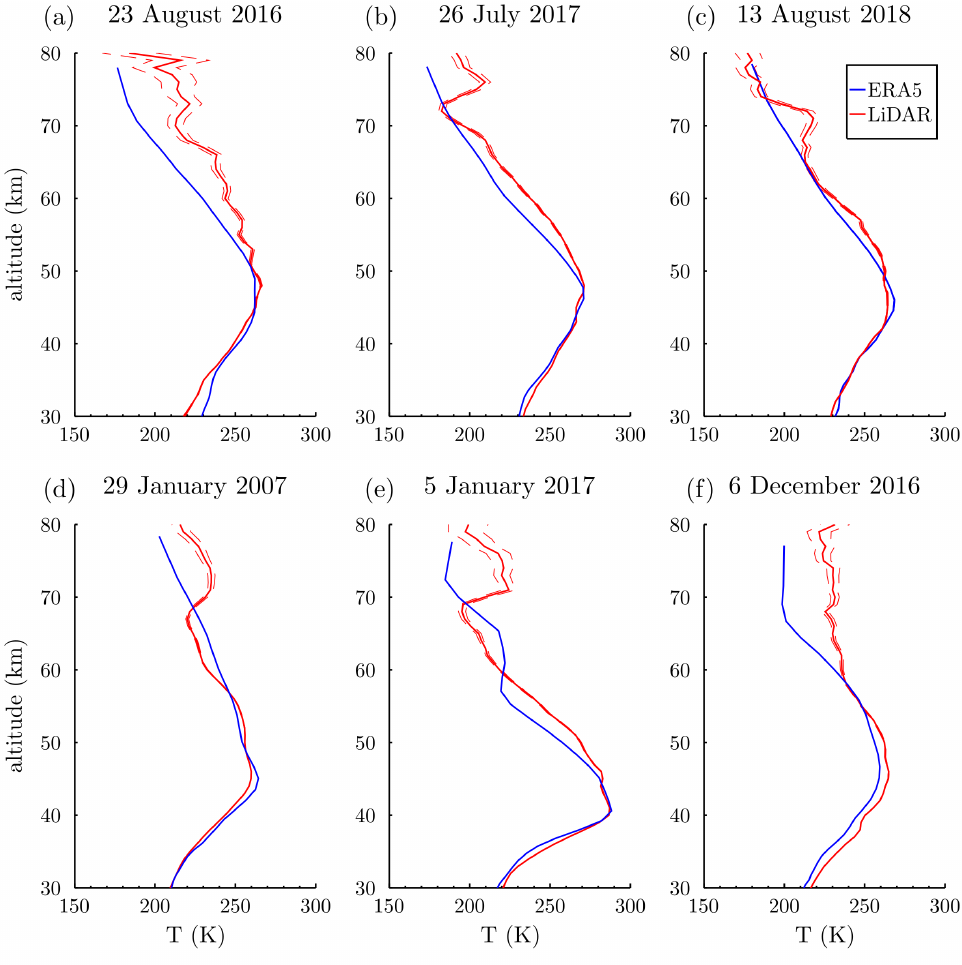
Figure 8. Temperature profiles from the LiDAR (solid red lines) and from the model (solid blue lines) for three dates in summer ( a – c ) and three dates in winter ( d – f ) chosen for illustrating the principal components found. Instrumental errors from the LiDAR are shown as well (red dashed